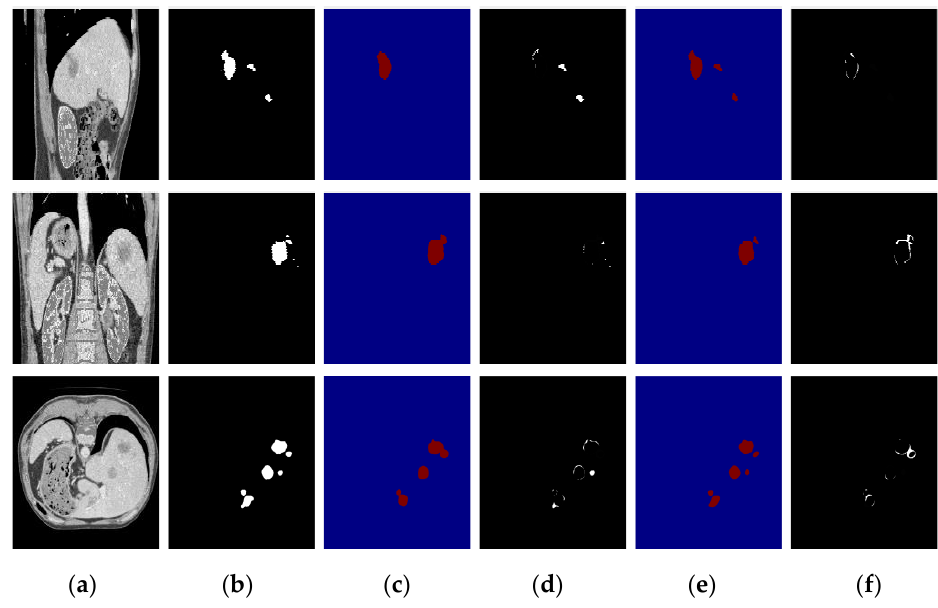
Figure 15. Segmentation result of a multiple-tumor area; the first row is the sagittal plane, the second row is the coronal plane, and the third row is the transverse plane. ( a ) CT image; ( b ) Ground truth; ( c ) DenseUNet segmentation results; ( d ) difference image between DenseUnet and ground truth; ( e ) the proposed algorithm’s segmentation results; ( f ) difference image between the proposed algorithm and ground truth.